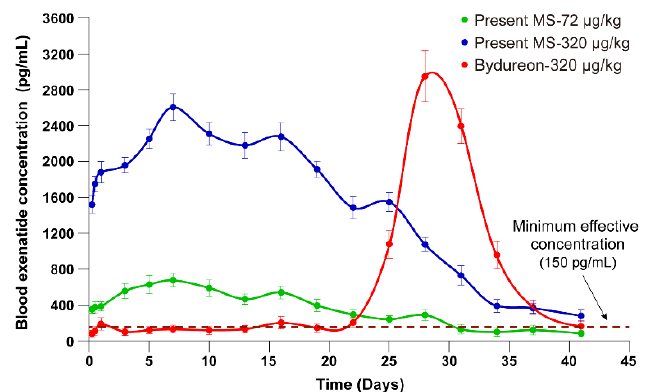
Figure 7. Plasma concentrations of exenatide released from the microspheres of the present study and commercial product Bydureon TM in rhesus monkeys (means ± SD, n = 5) ( p < 0.05).